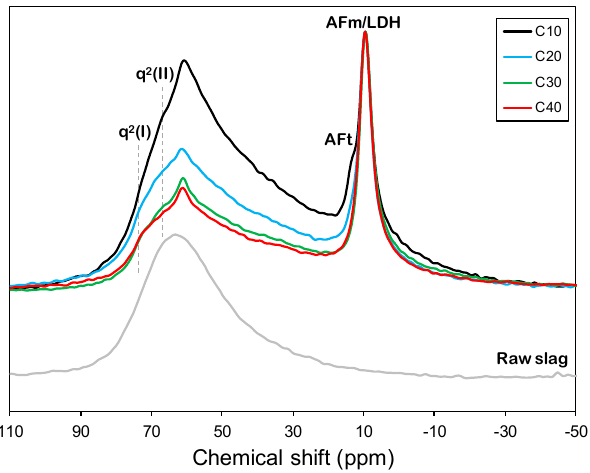
Figure 3. Normalized 27 Al MAS NMR spectra of raw slag and mixtures of slag and CCR.